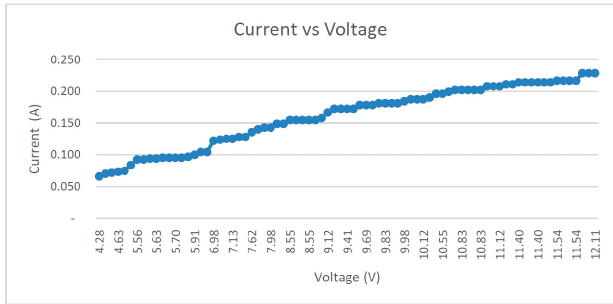
Figure 7. Graph of current vs. voltage of controlled state.